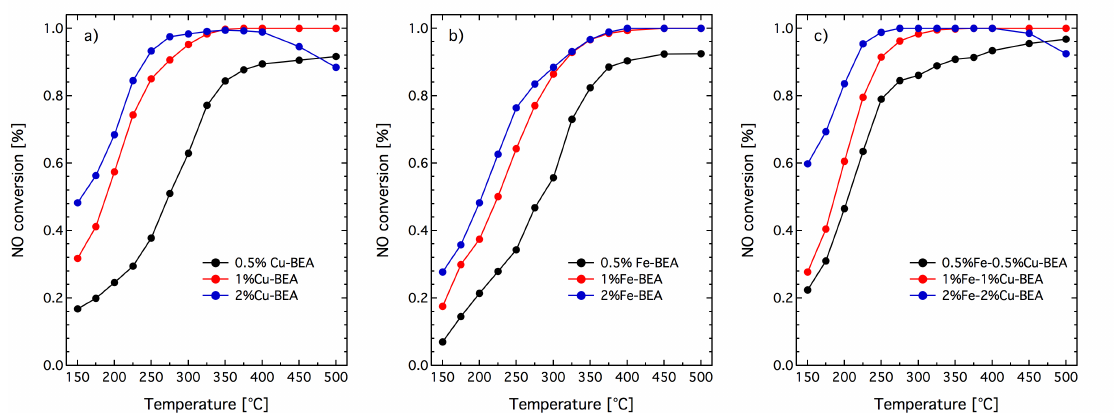
Figure 5. NO conversion profiles during NH 3 -SCR over the ion-exchanged ( a ) Cu-beta, ( b ) Fe-beta and ( c ) (Fe + Cu)-beta samples. The NH 3 -SCR experiments were performed using 400 vol.-ppm NO, 400 vol.-ppm NH 3 , 8 vol.% O 2 , 5 vol.% of water, and Ar as balance. The sample temperature